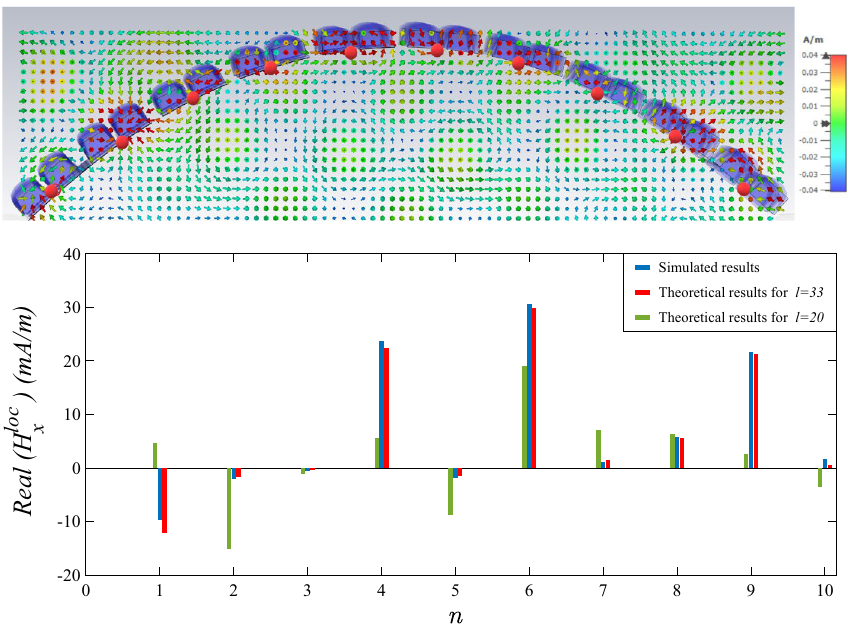
Simulated results Theoretical results for l=33 Theoretical results for l=20